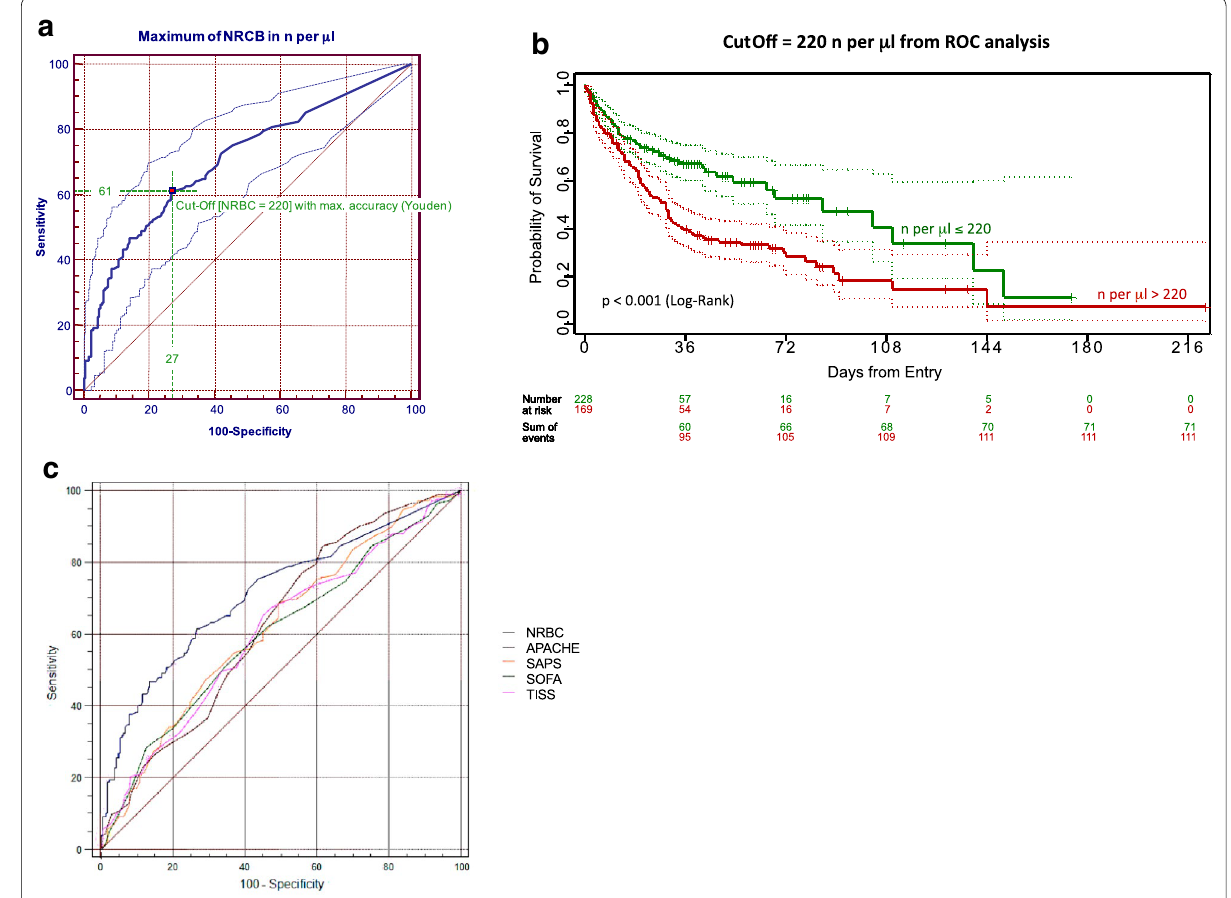
Fig. 4 a Receiver operator curve (ROC) for the assessment of predictive validity of NRBC measurements. The value that maximized the vertical distance between ROC and diagonal line (representing the highest sum of sensitivity and specificity) was used for calculation of a cutoff value, as described elsewhere [17]. ROC AUC: 0.71; 95% CI 0.66–0.75; p < 0.0001. b Probability of survival depicted as Kaplan–Meier curves of ARDS patients grouped by NRBC cutoff level of 220 NRBC/µl from ROC analysis. Log‑rank test: p < 0.001. c Receiver operator curves (ROC) for the assessment of predictive validity of NRBCs in comparison to severity of illness scores APACHE, SAPS, SOFA and TISS at ICU admission. NRBC AUC 0.713 (95% = confidence interval 0.665–0.758); APACHE AUC 0.626 (95% confidence interval 0.576–0.675); SAPS AUC 0.618 (95% confidence inter‑ = = = = val 0.567–0.667); SOFA AUC 0.60 (95% confidence interval 0.549–0.650); TISS AUC 0.605 (95% confidence interval 0.554–0.654). AUC of the = = = = = NRBC ROC curve was significantly different from those of the other parameters: pairwise comparison: NRBC vs. APACHE: p 0.018; NRBC vs. SOFA: = p < 0.001; NRBC vs. SAPS: p 0.009; NRBC vs. TISS: p 0.003). NRBC nucleated red blood cells; SAPS Simplified Acute Physiology Score; APACHE = =